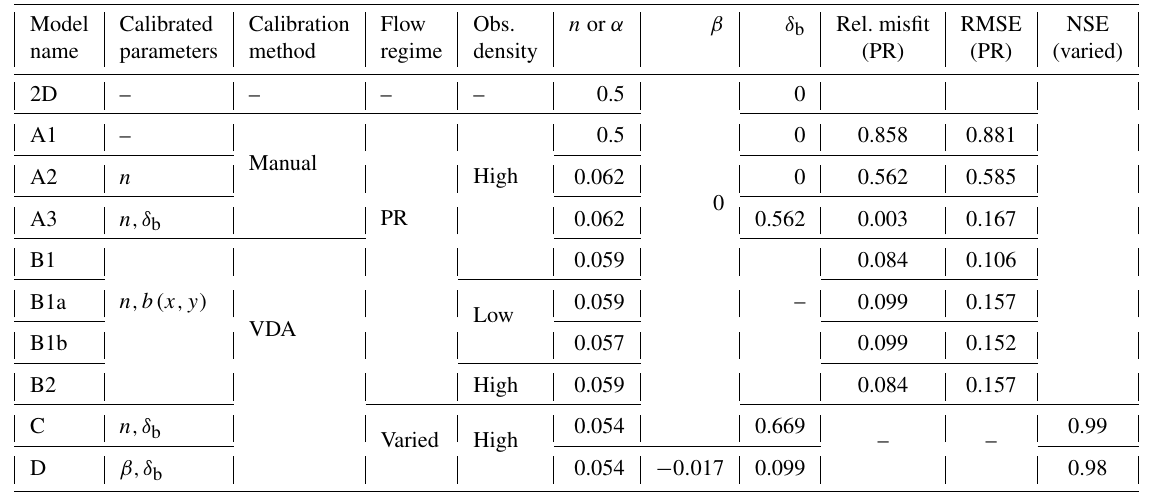
Table 3. Garonne models parameters and metrics. “PR” stand for permanent regime (discharge of 400m 3 s − 1 ). The “varied” flow event is non-flooding and has a mean discharge of 398m 3 s − 1 , with a minimum of 183m 3 s − 1 and a maximum of 702m 3 s − 1 . “High” observation density corresponds to 720 stations or one station per 100m. “Low” observation density corresponds to 72 stations or one station per 1km.